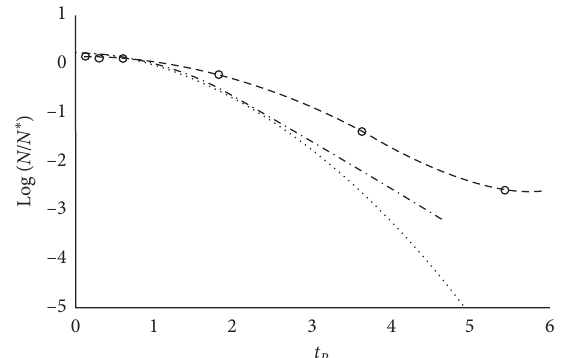
Figure 6: Deviation from the decay model (dotted curve) observed for Clostridium in broth at 85 ° C (open circles) [16] and Pseudo- monas aeruginosa at 37 ° C (point-dotted curve)